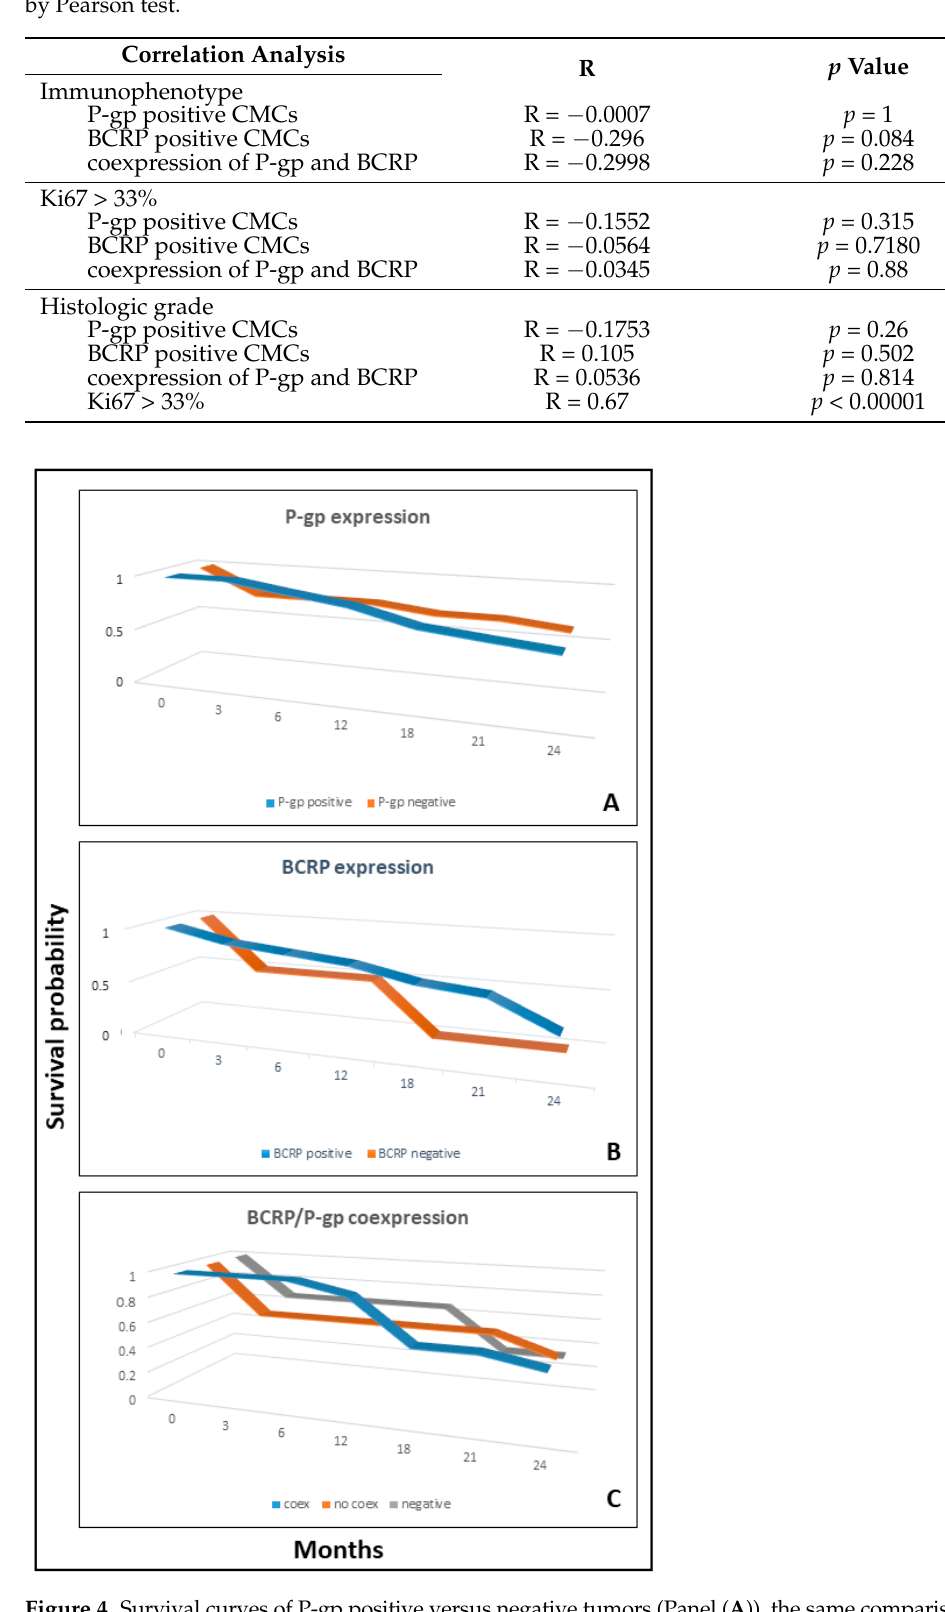
Table 3. Correlation of P-gp, BCRP expression or their coexpression with other variables of the study by Pearson test.